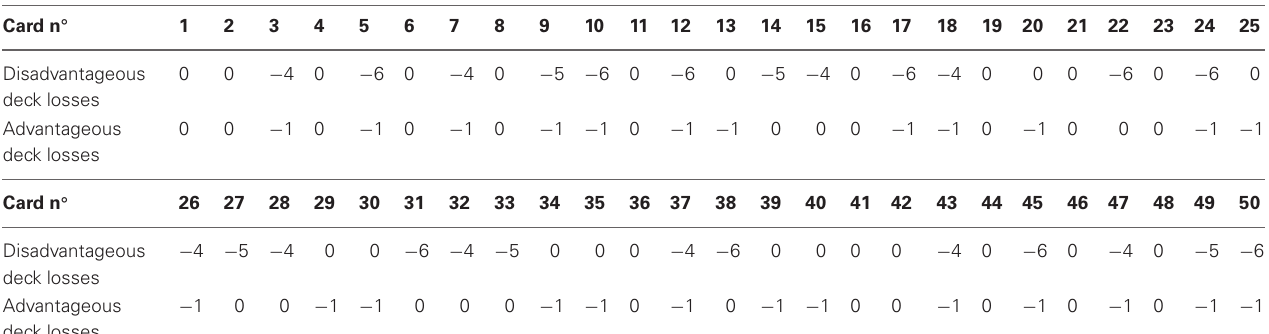
Table 2 | Outcomes associated with each card in the advantageous and disadvantageous